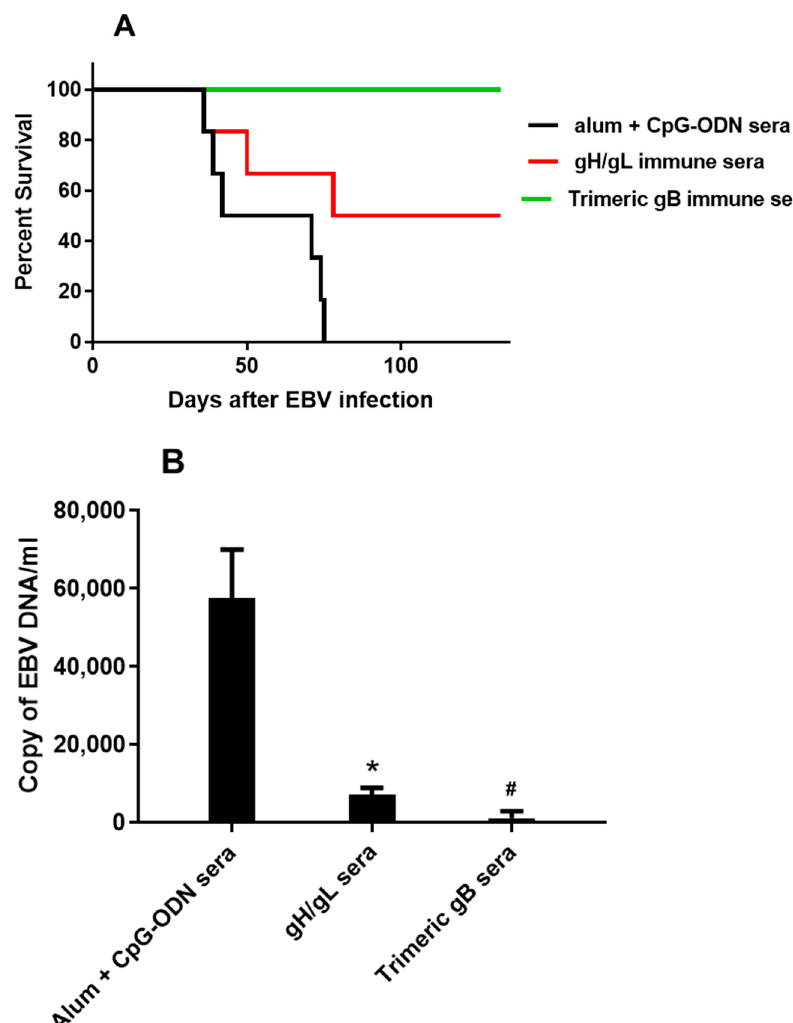
Figure 4. Immune sera from rabbits immunized with EBV gH/gL or EBV trimeric gB protected humanized NOG mice from death caused by high dose EBV infection, and markedly decreased the EBV load in peripheral blood. Humanized NOG mice were made by intravenous injection of human CD34+ HSCs isolated from cord blood. After the human hemato-immune system was reconstituted, 3 groups ( n = 6) of humanized NOG mice were injected intraperitoneally with 300 µL of the day 52 pooled sera from rabbits immunized with EBV gH/gL, EBV trimeric gB or adjuvant alone (alum + CpG-ODN) respectively. Two hours following intraperitoneal injection of rabbit sera, humanized mice were infected intravenously with ~1 × 10 3 TD 50 of EBV (AKATA), a dose that induces B cell lymphoproliferation and fatality by 10 weeks (67). ( A ) Survival curve 132 days post-EBV infection. ( B ) Copy number of EBV DNA in peripheral blood of humanized mice 35 days after high dose EBV infection. Significance *, # p < 0.05 compared to the humanized mice receiving the sera from rabbits injected with adjuvant